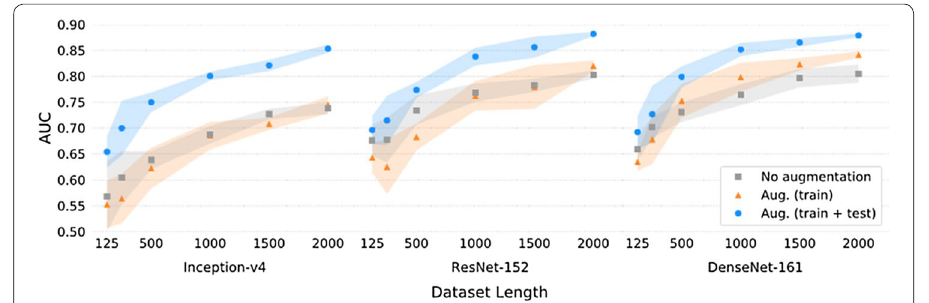
Fig. 32 Impact of test-time data augmentation for skin lesion classification